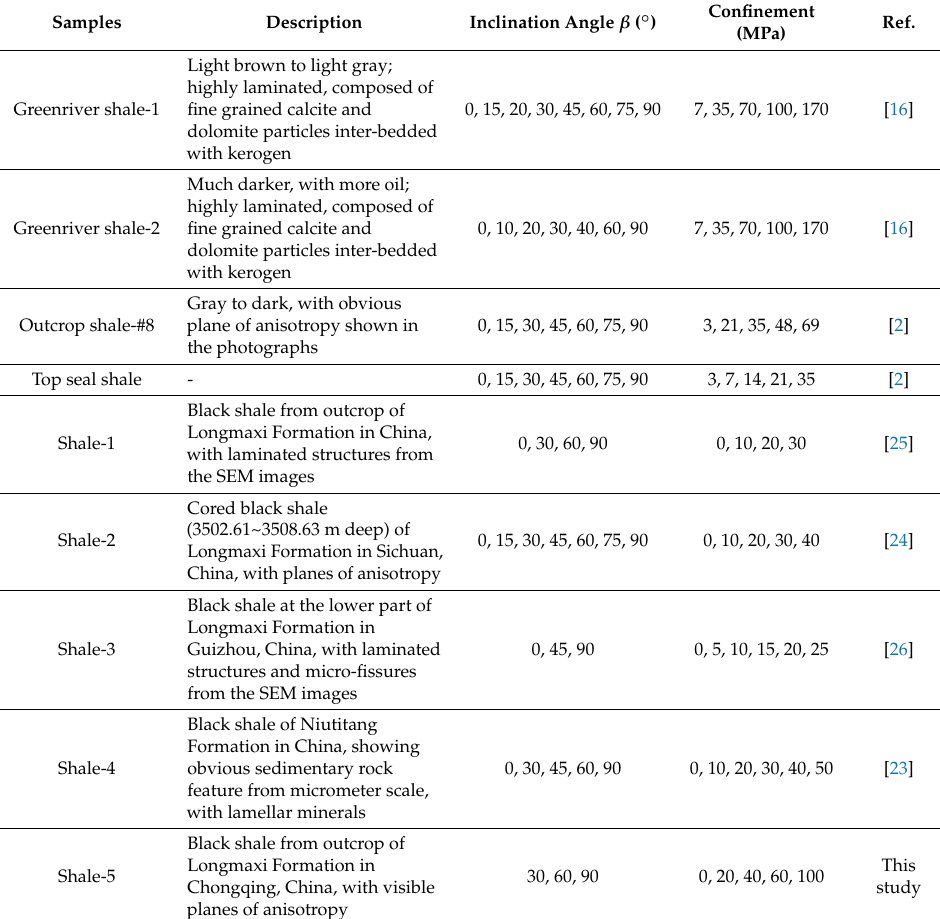
Table 2. Basic information of the samples and test